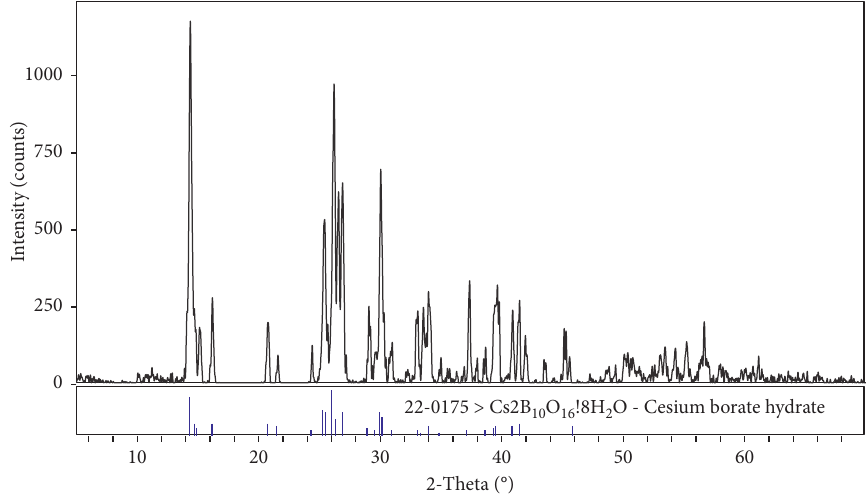
Figure 1: The X-ray diffraction pattern of β -CsB